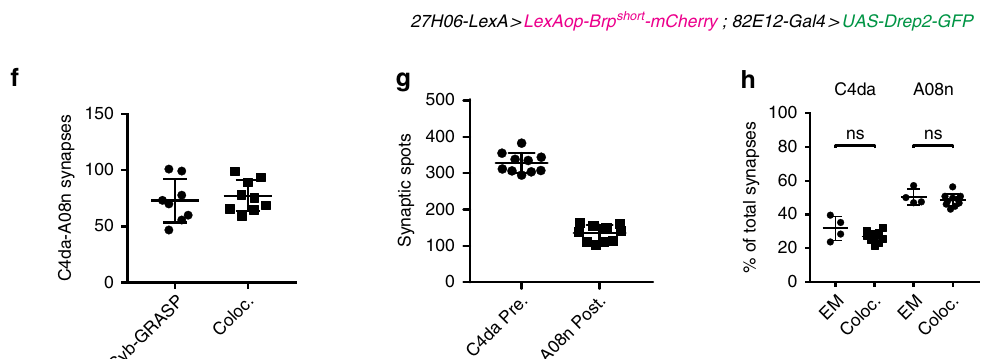
Fig. 1 Quantitative analysis of C4da – A08n neuron connectivity. a Schematic model of a larval brain with A08n neurons (green), C4da (magenta), and C2da/C3da axon projections (blue/cyan) into the VNC and schematic expansion of abdominal segments 5 and 6. b Schematic model of Syb-GRASP- mediated GFP reconstitution. c C4da – A08n Syb-GRASP signal in a single hemisegment showing anti-Fas3 staining (blue), reconstituted GFP (green), and merge. Scale bar = 5 µ m. d C4da presynaptic (Brp short -mCherry) and A08n postsynaptic (Drep2-GFP) marker expression and example confocal image of abdominal segments 5 and 6 showing expressed markers in C4da (magenta) and A08n (green). e Hemisegment showing Brp short -mCherry in C4da (magenta), Drep2-GFP in A08n (green), and merge. Scale bar = 5 µ m. f Quanti fi cation of Syb-GRASP puncta compared to synaptic marker colocalization. Syb-GRASP n = 8, colocalization n = 9 ± SD. g Quanti fi cation of C4da presynaptic and A08n postsynaptic marker puncta per hemisegment. n = 10 ± SD. h Comparison of EM and light microscopic marker colocalization analyses. Percentages of counted C4da presynapses connected to A08n or A08n postsynapses connected to C4da showed no signi fi cant differences between both methods. EM: C4da n = 4, A08n n = 4, confocal: C4da n = 10, A08n n = 10. C4da: P = 0.06, A08n: P = 0.43 ± SD. Unpaired two-tailed t